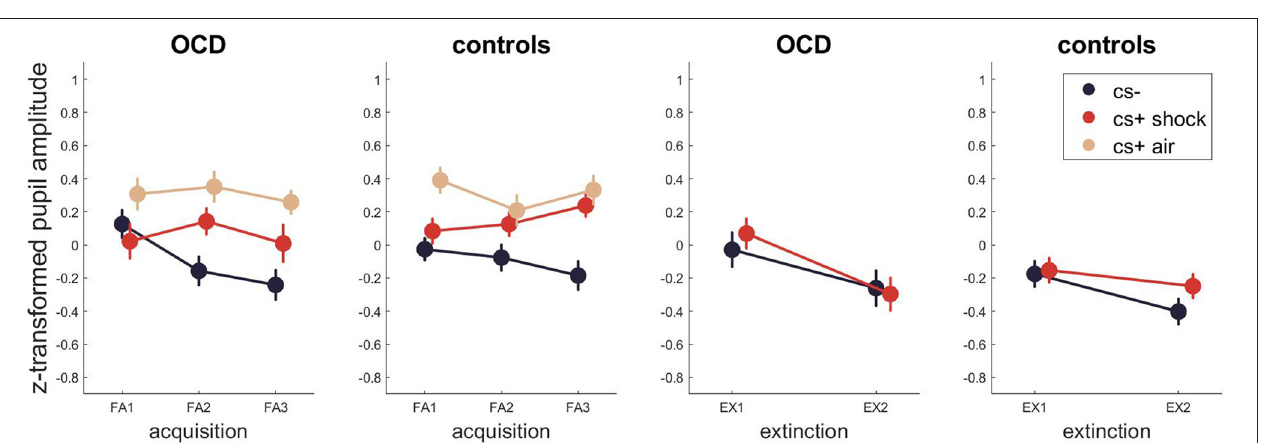
FIGURE 3 | Pupil dilations across fear acquisition and extinction. Error bars are standard errors of the mean.